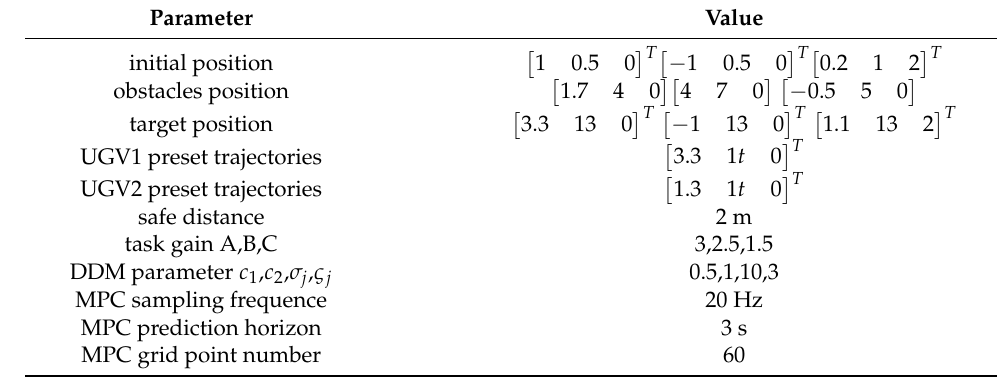
Table 1. Parameter values used in the simulation.